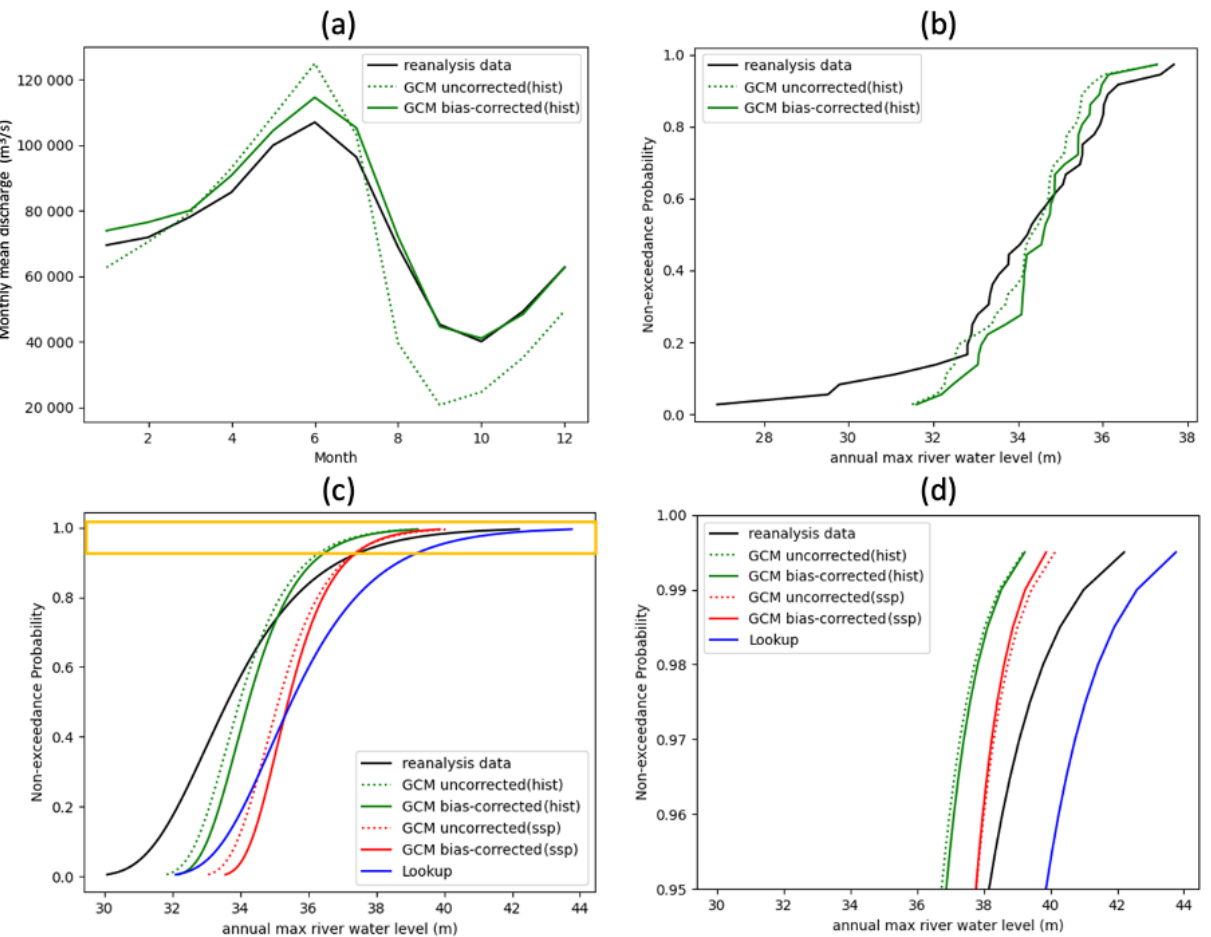
Figure 6. Comparison of reanalysis data, uncorrected GCM, bias-corrected GCM, and the lookup method at the GRDC Itapeua station (63.0278 ◦ W, 4.0578 ◦ S). (a) Climatology of monthly mean discharge, (b) exceedance probability curve of annual maximum river water levels from 1980 to 2014, (c) Gumbel distribution of annual maximum river water levels, and (d) enlarged view of the orange square in panel (c)